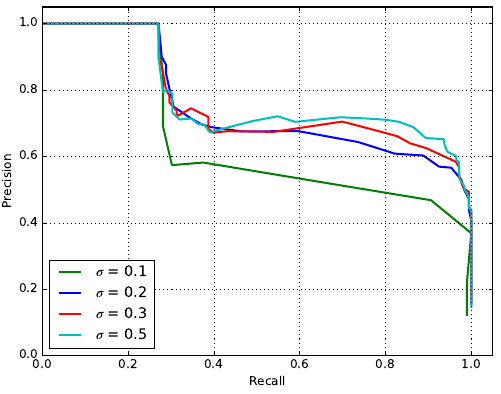
Figure 9. Precision-Recall curve for different values for σ